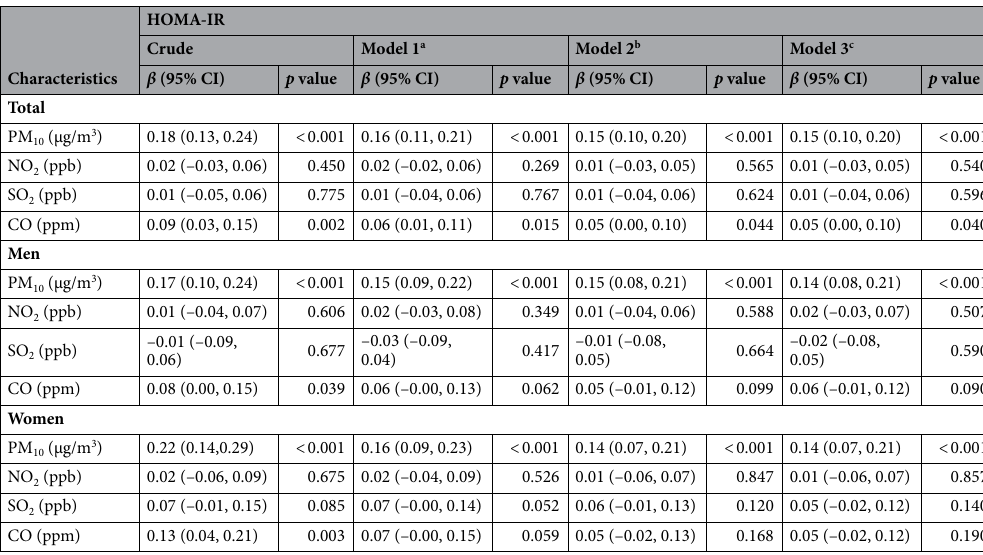
Table 3. Regression results for the association between long-term exposure to ambient air pollution and HOMA-IR. HOMA-IR homeostasis model assessment of insulin resistance index, PM 10 particulate matter with aerodynamic diameter ≤ 10 μm, NO 2 nitrogen dioxide, SO 2 sulfur dioxide, CO carbon monoxide, CI confidence interval. The beta coefficients and 95% CIs of air pollutants were scaled to the interquartile range (IQR) for each air pollutant: 11 μg/m 3 for PM 10 , 14 ppb for NO 2 , 2 ppb for SO 2 , and 0.2 ppm for CO. a Model 1 was adjusted for age, BMI, smoking status (never, former, or current smoking), alcohol consumption (never, former, or current consumption), regular physical activity (yes or no), hypertension, and dyslipidemia. b Model 2 included the variables in Model 1 plus VAT and SAT areas as covariates. c Model 3 included the variables in Model 1 plus VAT area as a covariate.